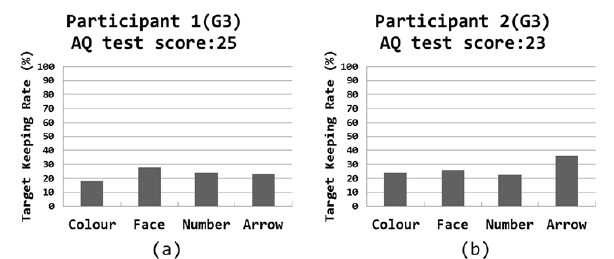
Figure 9. TKR of the participants in Group 3 (Slightly higher than average autis- tic traits), (a) Participant 1(G3), male, AQ score: 25; (b) Participant 2(G3), female, AQ score: 23.